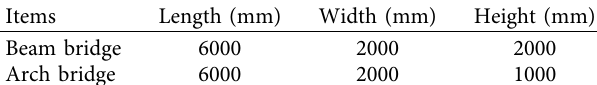
Figure 5: The experimental site and wood model, (a)layout of experiment site, (b)the arch bridge model, and (c)the beam bridge model. Table 1: The parameters of bridge